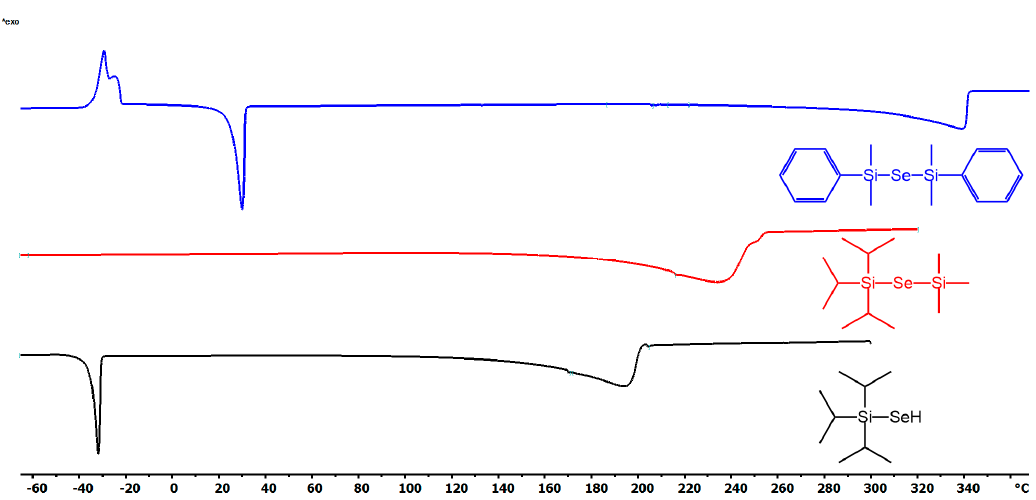
Figure 1. DSC records for newly prepared organoselenium compounds.